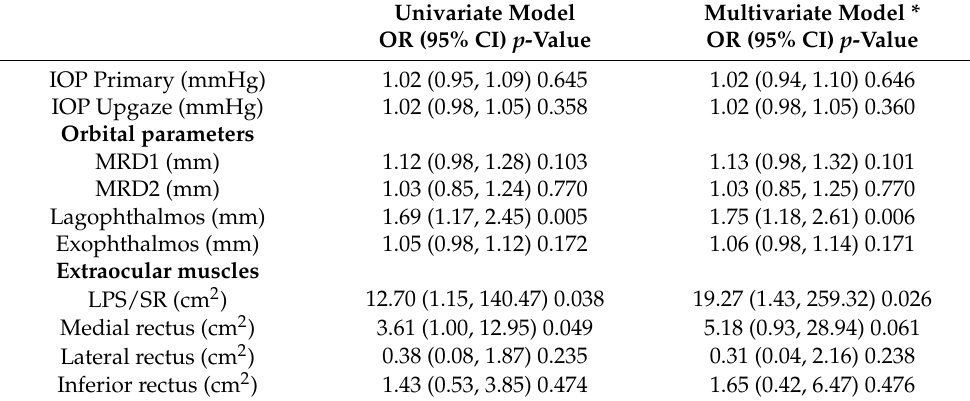
Table 3. Association of corneal striae and measurement parameters in TAO eyes (N = 106).